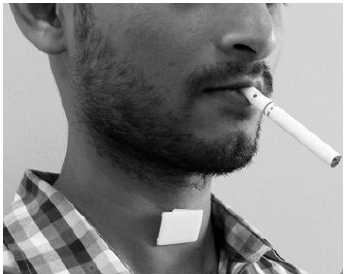
Figure 7. Acoustic sensor attached to the suprasternal notch to detect smoke related breathing.